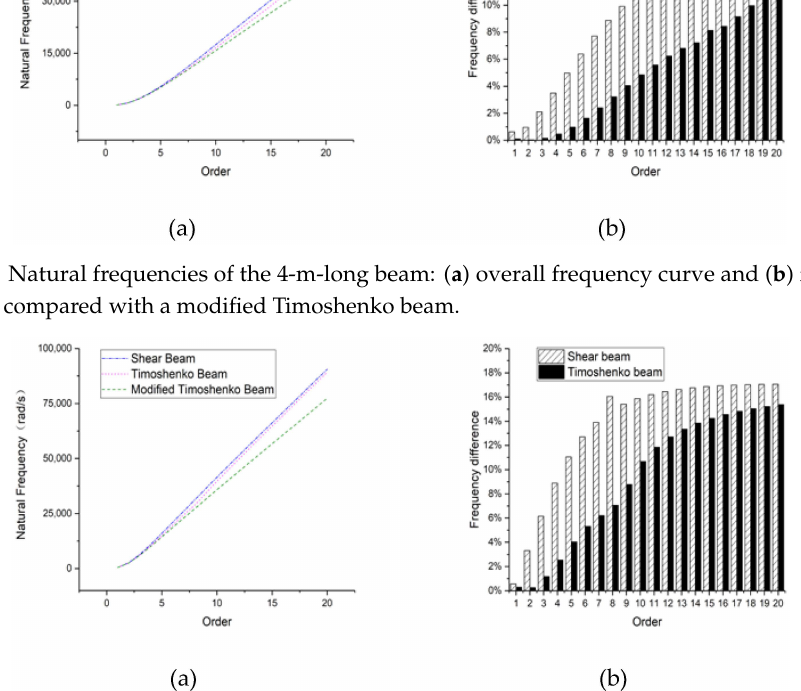
Figure 30. Natural frequencies of the 2-m-long beam: ( a ) overall frequency curve and ( b ) frequency di ff erence compared with a modified Timoshenko